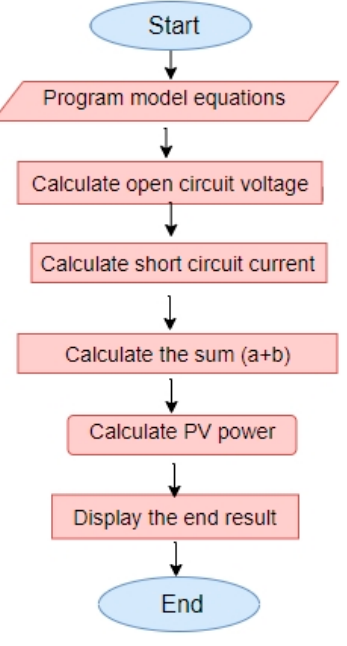
Figure 2. Flowchart for solar cell implementation in MATLAB.